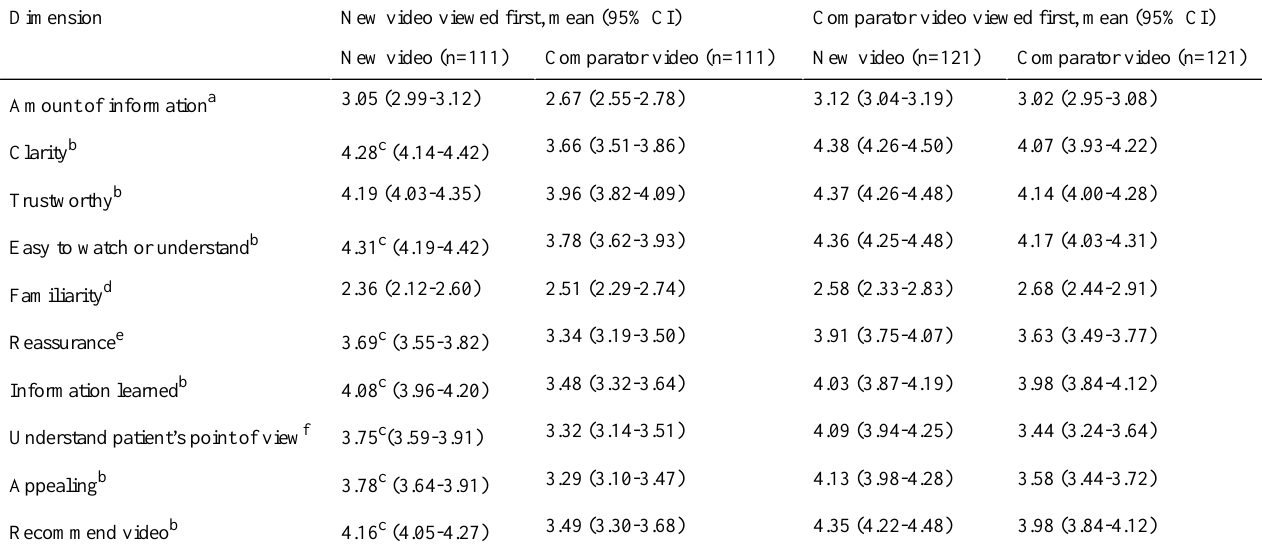
Table 6. Evaluation of the dimensions of the current and revised videos, stratified by the order of presentation of videos.